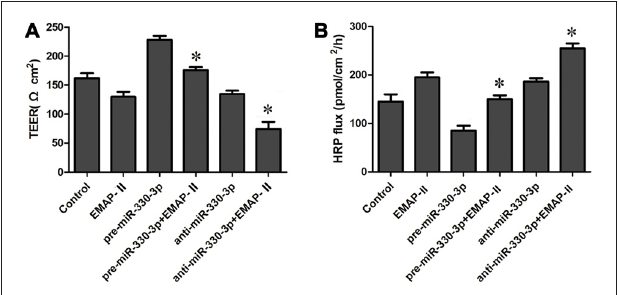
FIGURE 2 | Effects of overexpression or silencing of miR-330-3p on the permeability of BTB in EMAP-II treated GECs. (A,B) TEER and HRP assays were used to measure the permeability of BTB. Data represent means ± SD ( n = 5, each). ∗ P < 0.05 vs. EMAP-II